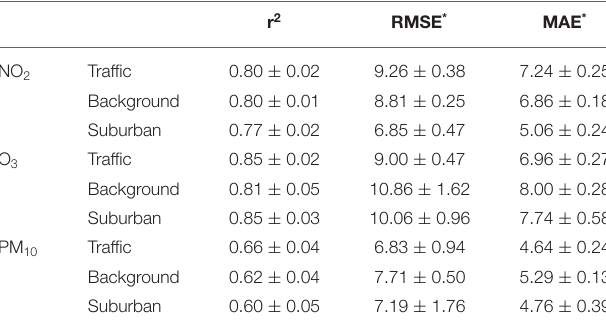
TABLE 1 | The results of the k-fold cross validation for the XGBoost model using 10 folds and displayed as the average value ± standard deviation.